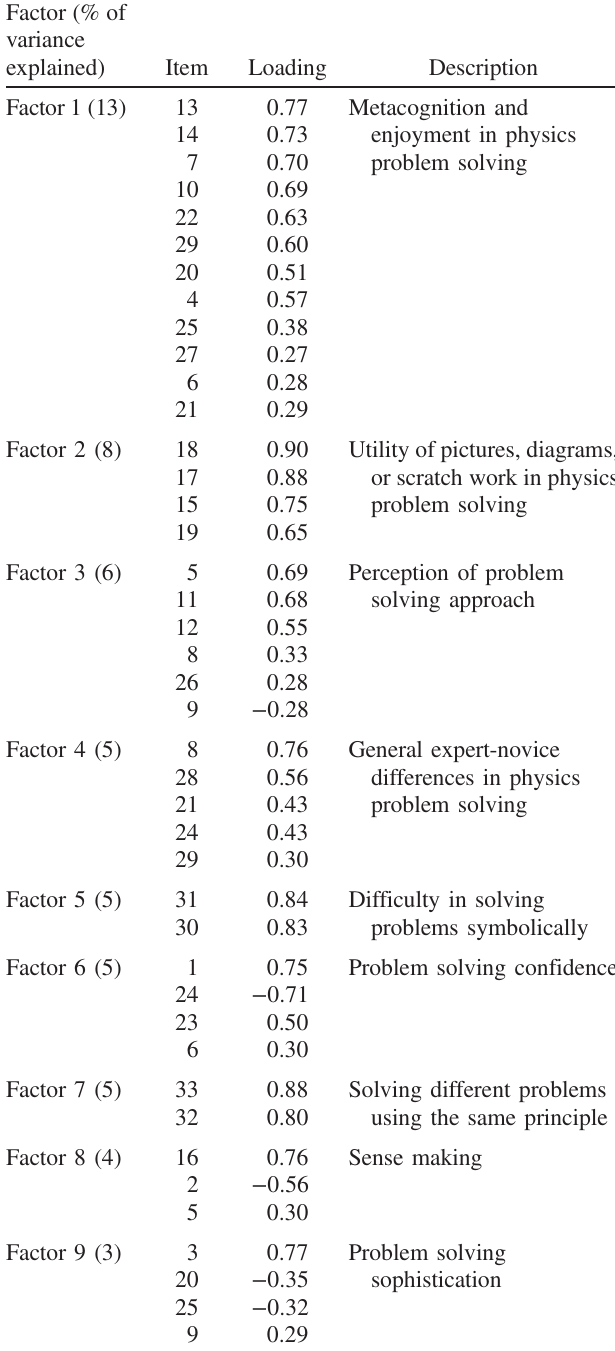
TABLE I. Principal component analysis results featuring 9 primary factors and description, reproduced from Mason [49]. Note that a given question can be classified into more than one